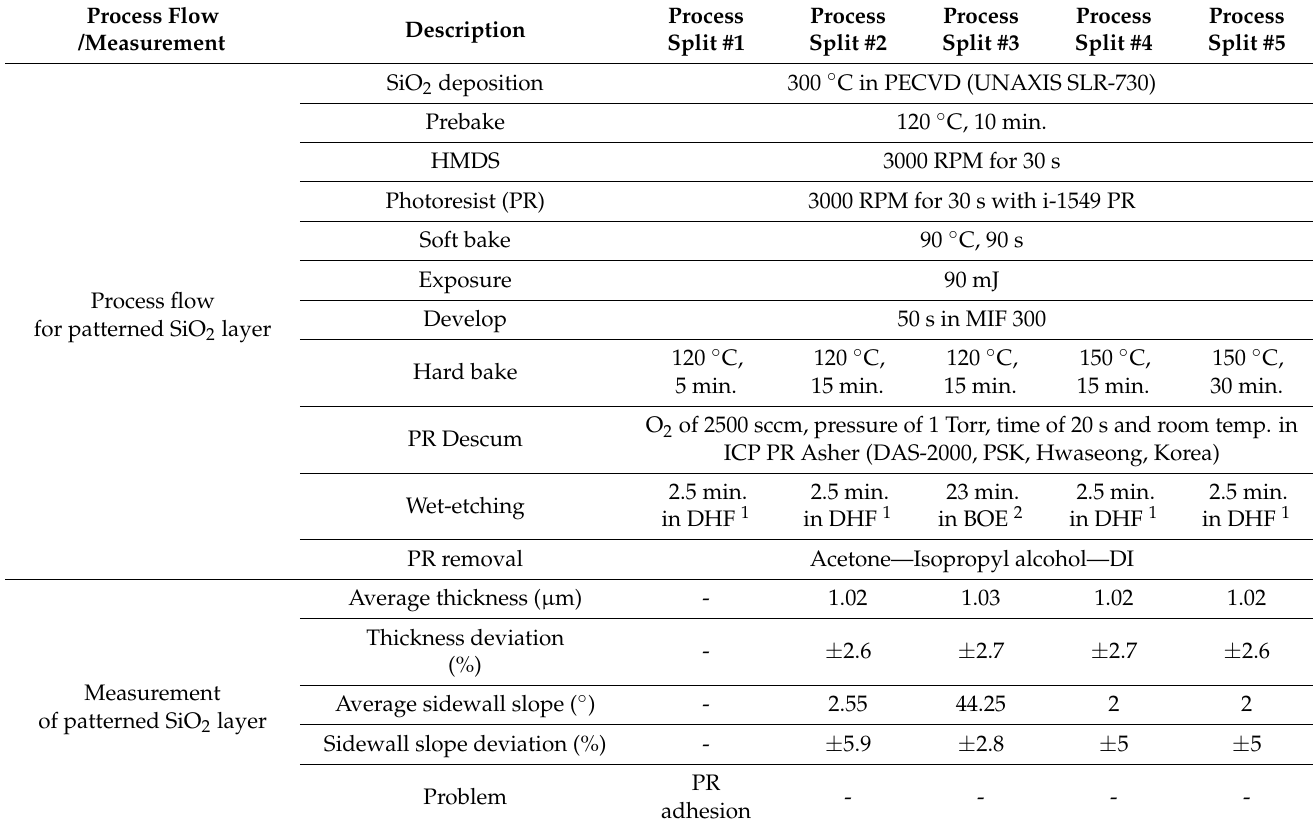
Table 1. Specific process flow and measured results for the SiO 2 layer with small sidewall slopes. Process Flow